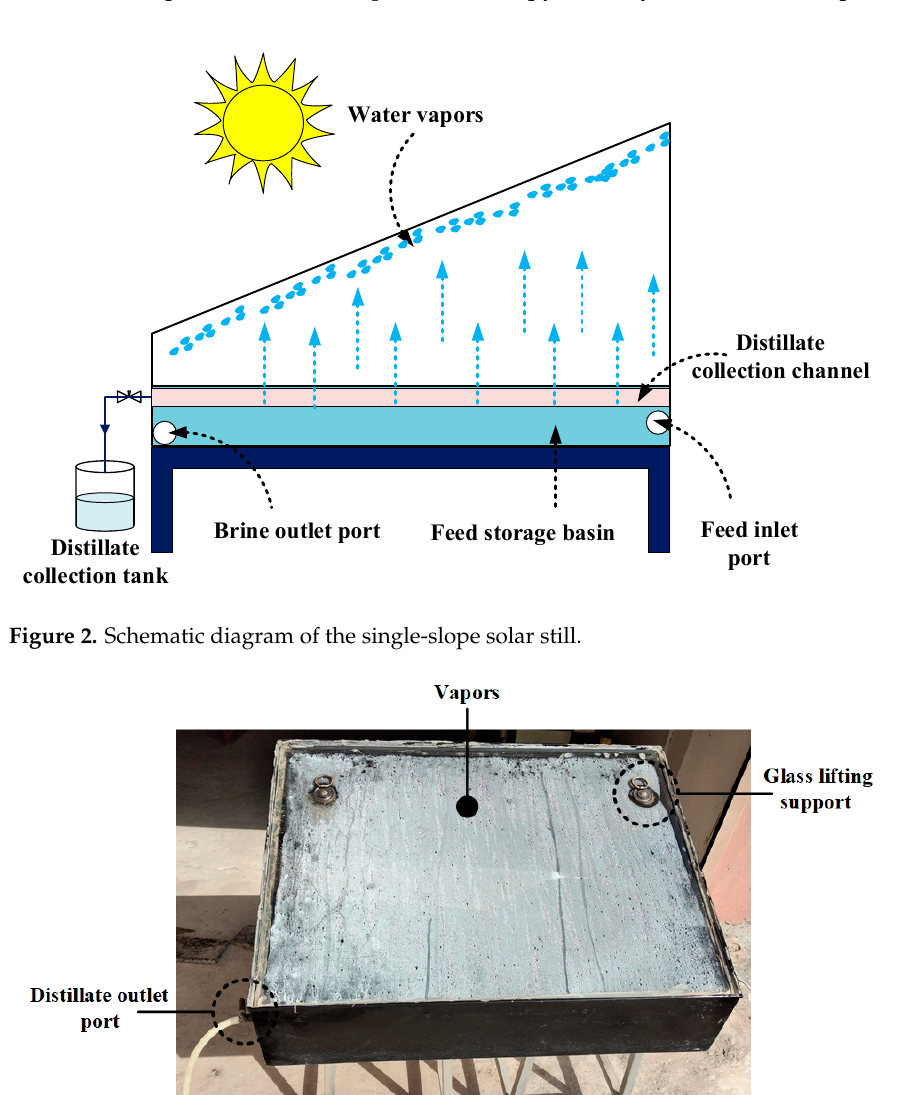
Figure 4. Schematic diagram of the pyramid solar still. Figure 5. Pyramid shape solar still experimental setup.